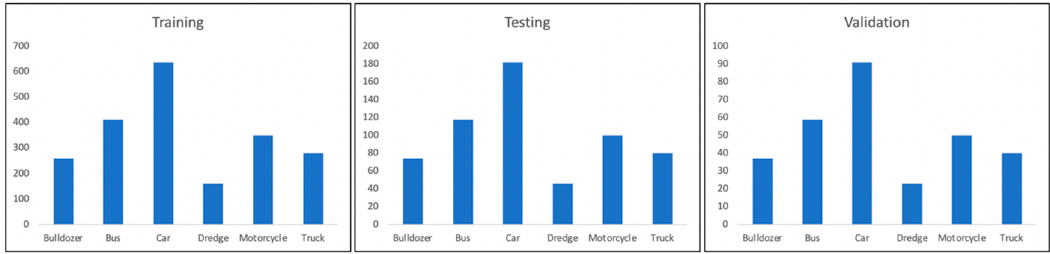
Figure 8. Parameters of the training, testing and validation samples.